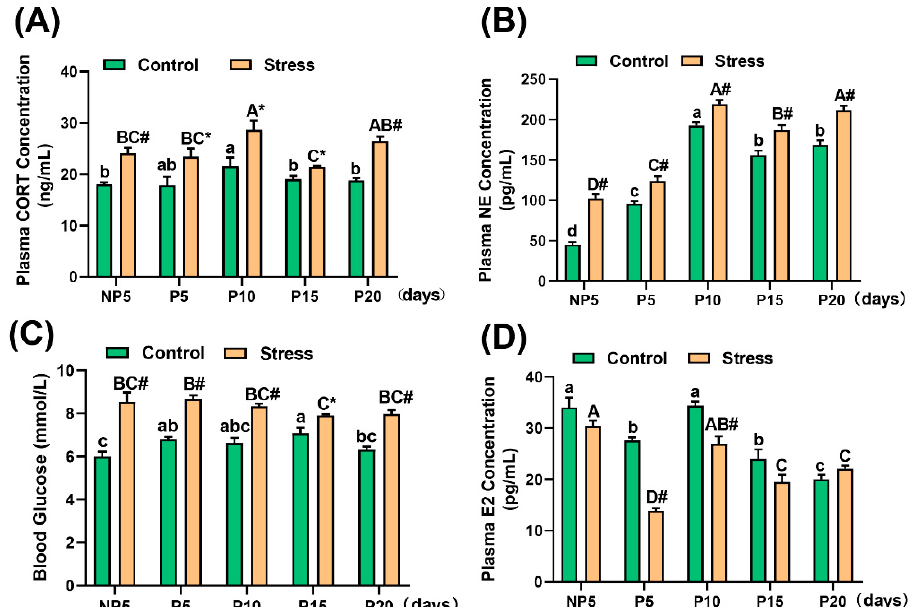
Figure 3 . Changes in plasma hormone levels in pregnant mice . Restraint stress caused an increase in corticosterone (CORT) ( A ), norepinephrine (NE) ( B ), and blood glucose ( C ) levels but a decrease in oestradiol (E2) ( D ) in the plasma of pregnant mice. Restraint stress caused disorders of stress hormones and reproductive hormone levels, resulting in endocrine disorders. The data are expressed as the mean ± SEM. Lowercase letters in the column (a, b, c, d) represent the differences between NP5 ( n = 10), P5 ( n = 10), P10 ( n = 10), P15 ( n = 10), and P20 ( n = 10) in the control group ( p < 0.05), and uppercase letters in the column (A, B, C and D) represent the differences between NP5 ( n = 10), P5 ( n = 10), P10 ( n = 10), P15 ( n = 10), and P20 ( n = 10) in the stress group ( p < 0.05). *p < 0.05 and #p < 0.01 were used to denote the significance of the stress group compared with the corresponding age of the control group.